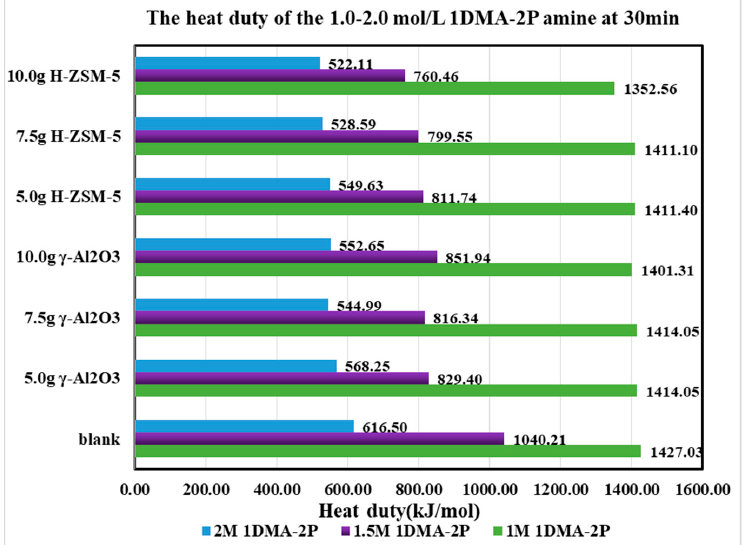
Figure 11. The heat duty of 1DMA-2P at first 30 min from 1.0 to 2.0 mol/L at 363 K and 1 atm.